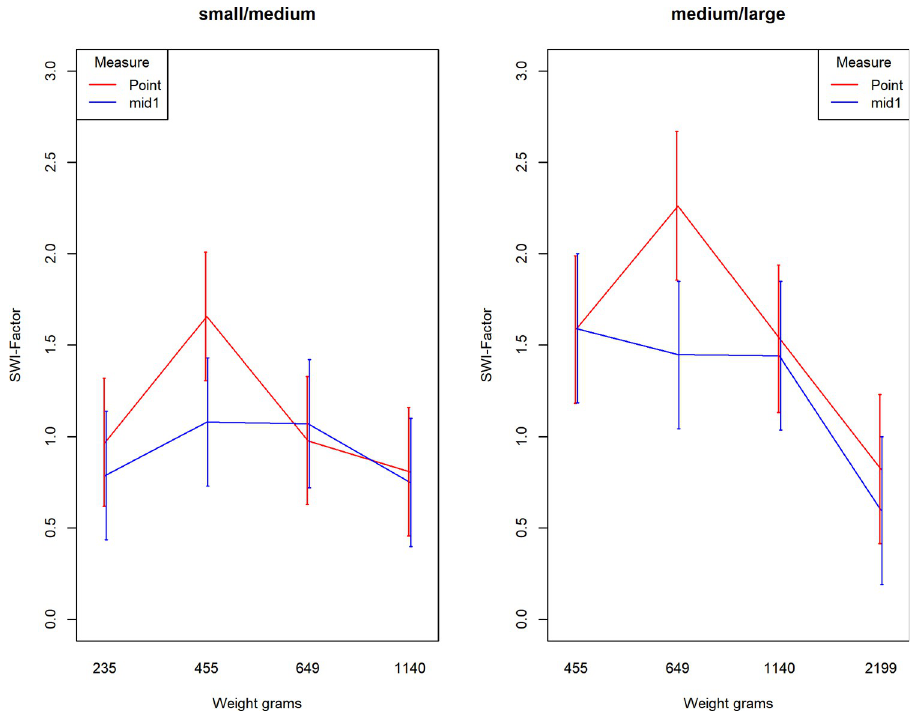
Fig 4. Average SWI-factor depending on weight and judgment method. Separate lines for SWI-factor for small/ medium (solid) and medium/large (dotted) comparisons. Whiskers indicate 95%-CI’s.